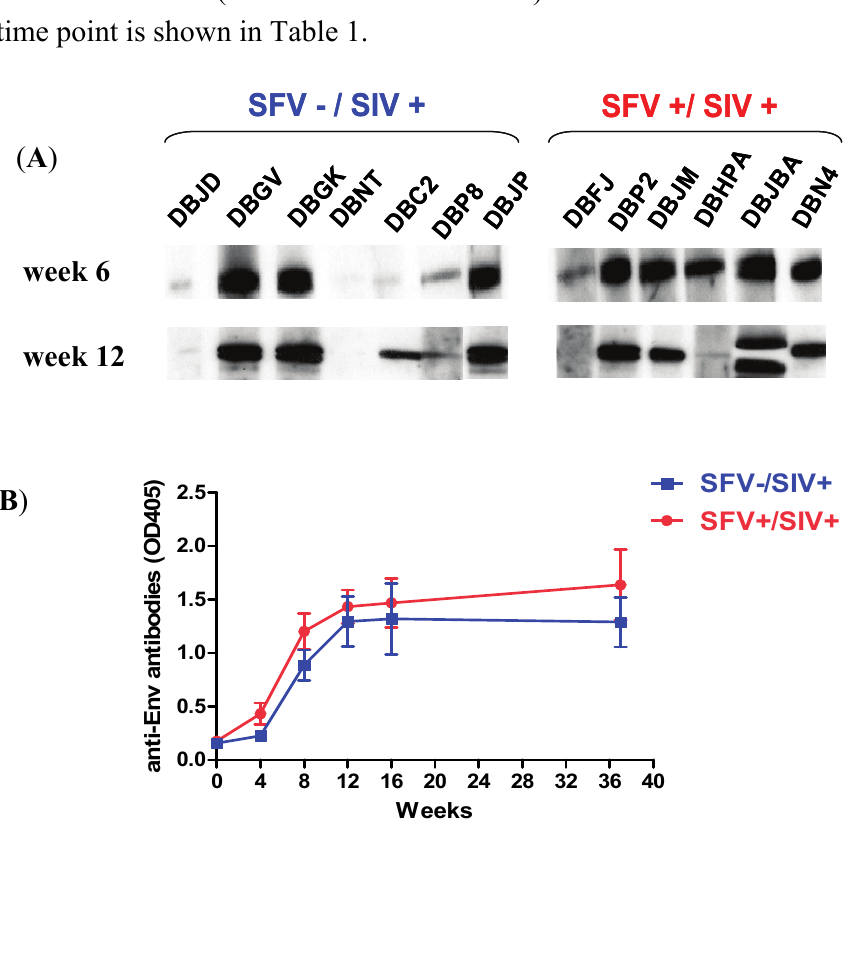
Figure 6. Evaluation of SIV Gag and Env antibodies. ( A ) Plasma samples from week 6 and week 12 were analyzed for Gag antibodies by Western blot assays using p27 antigen. ( B ) Animals that were positive for anti-gp120 antibodies in a Western blot assay using SIV-infected cell lysate were further analyzed by ELISA using 1:100 dilution of plasma and SIV gp120 antigen. The mean ± SEM of animals in the SFV positive group and mac239 SFV negative group is shown for selected time points. The number of animals at each time point in the case of the SFV positive group were: five for week 0, 4, 12, and 16 (DBP2, DBR7, DBJM, DBJBA, and DBN4), four for week 8 (no sample was available from DBR7) and 37 (DBN4 died at week 34); and the number of animals in the SFV − group were: six for week 0, 4, 8, and 12 (DBLM, DBGV, DBGK, DBC2, DBP8, and DBJP) , and five for week 16 and 37 (DBLM died at week 14). Data for week 4 and week 37 or terminal time point is shown in Table